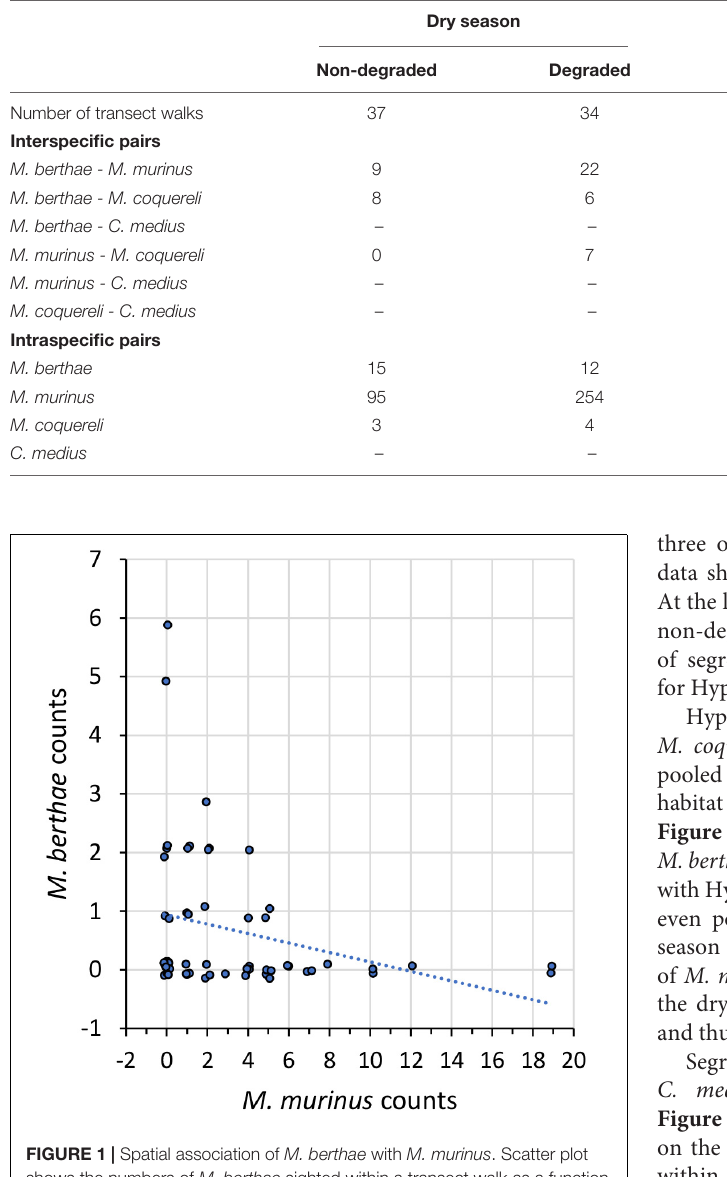
Competition Between Microcebus spp. Mouse lemur coexistence appears to be stabilized by avoidance of heterospecific individuals and movements in a spatio-temporally varying environment. Spatial segregation between the mouse lemurs was indicated by the pooled data at the regional and